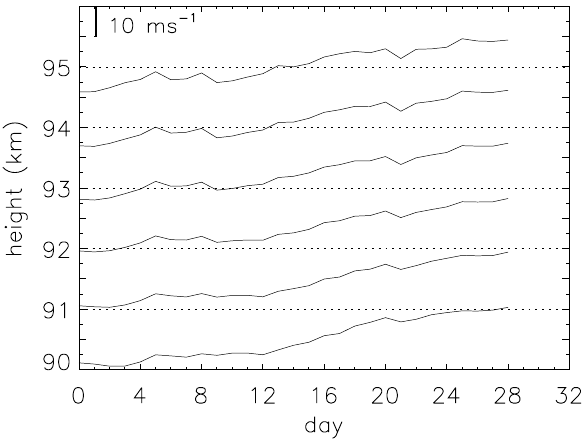
Fig. 4. Background wind derived from moving averaged velocities using a 16-day sliding window with a 1-day